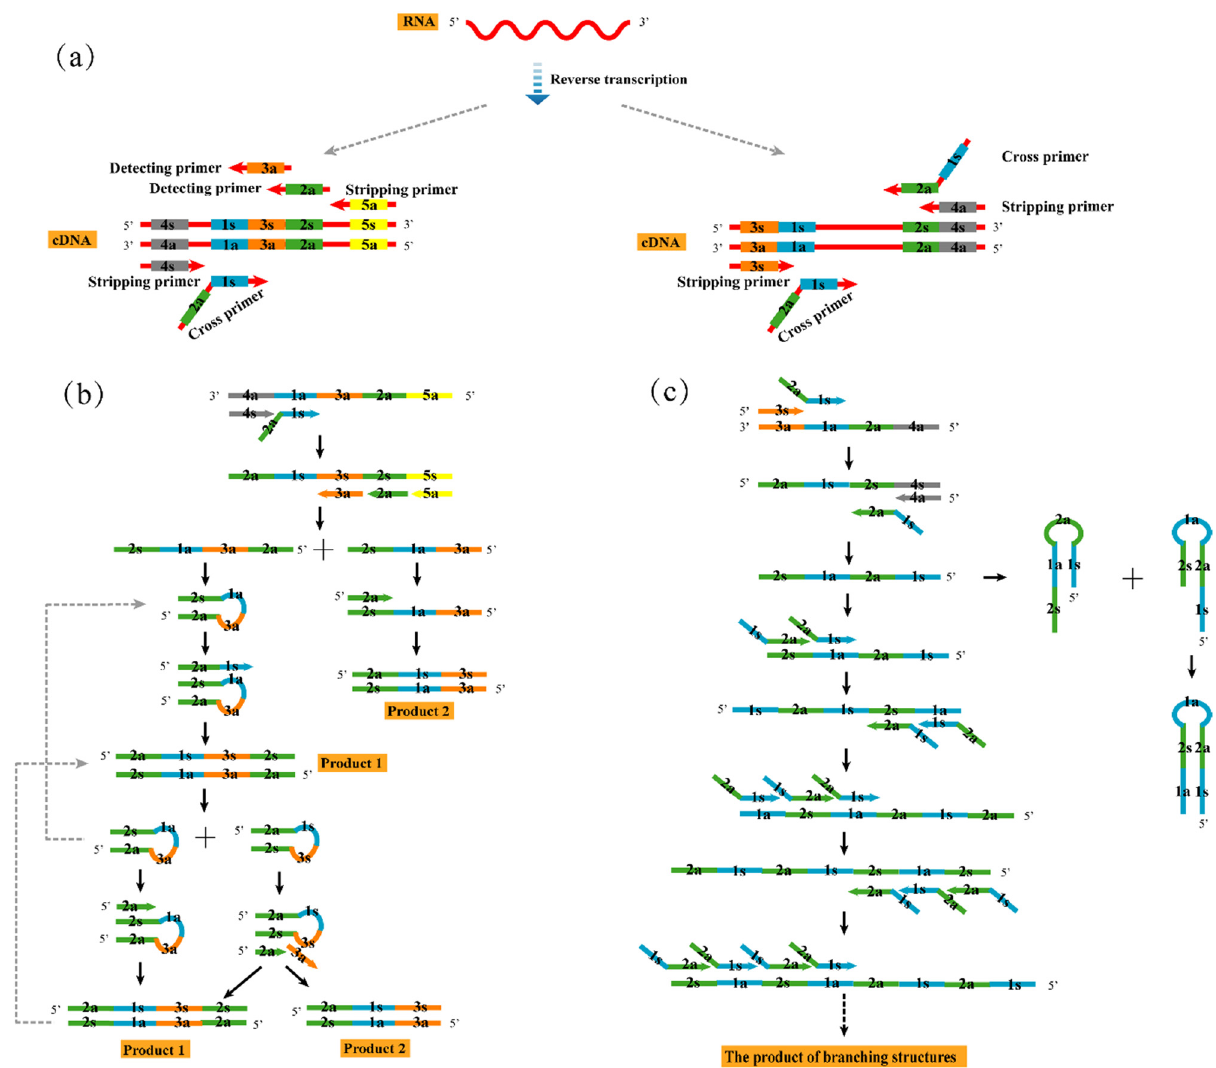
Figure 5: The schematic diagram of RT - CPA for RNA detection. ( a ) Reverse transcription to form cDNA. ( b ) The process of single crossing CPA. A cross primer ( 2a1s ) , two stripping primers ( 4s and 5a ) and two detection primers ( 2a and 3a ) are required for the whole reaction